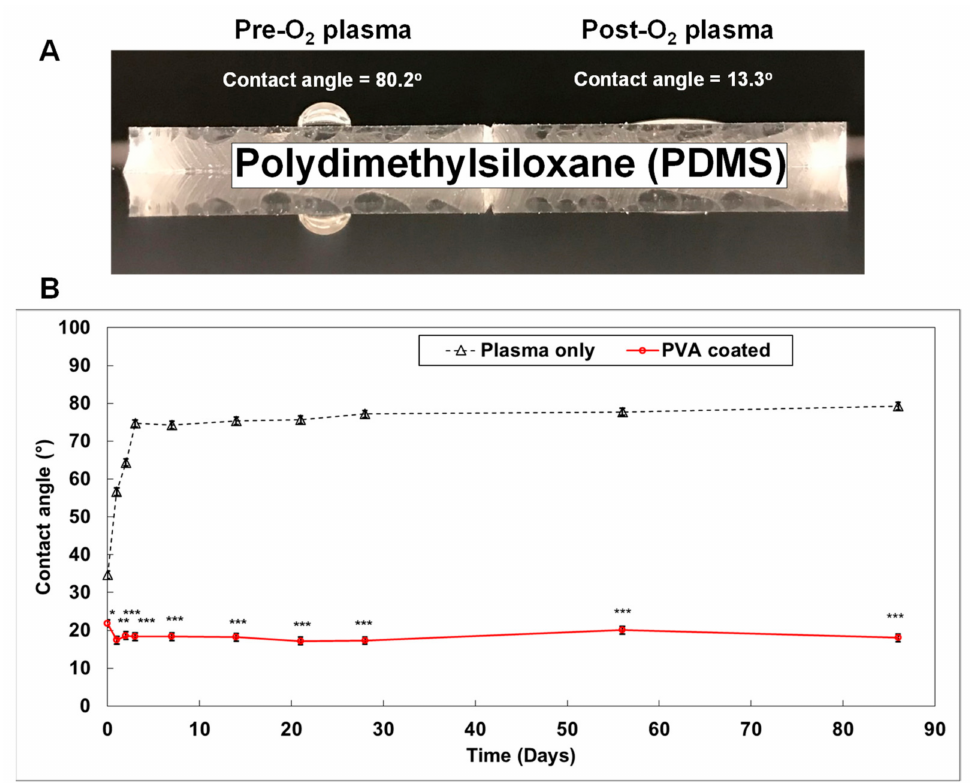
Figure 3. Generating a smart PDMS by modifying a hydrophobic PDMS surface. PDMS is a highly hydrophobic material ( A ). When the PDMS surface is exposed to oxygen plasma for 30 s, it becomes highly hydrophilic (contact angle = 13.3 ◦ ). It returns to a hydrophobic status within 3 days (B; black dotted line). However, the polyvinyl alcohol (PVA) coated PDMS surface maintained a hydrophilic status for over 3 months (( B ); red solid line). ( p-values : * <0.05, ** <0.005, *** <0.0005; number of samples: n = 3 in each condition; data represented as mean ±